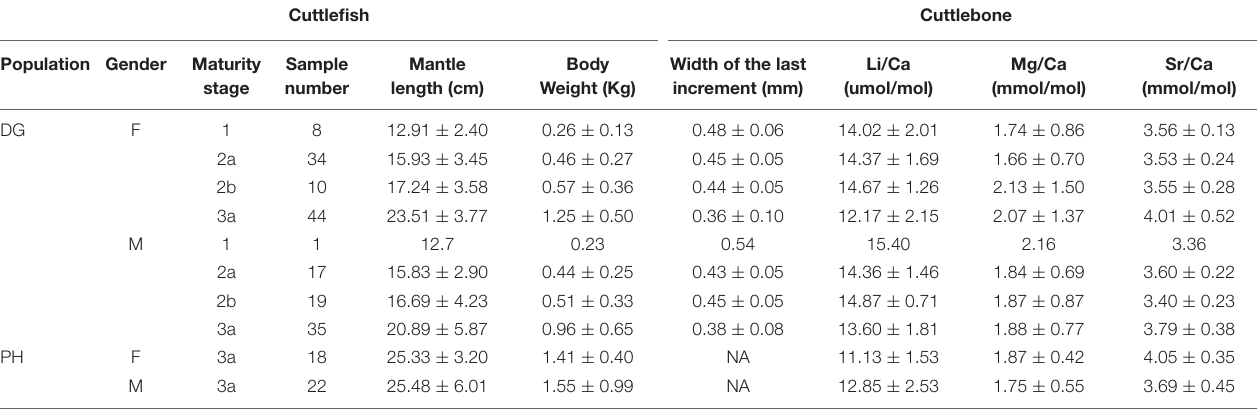
TABLE 2 | Wild cuttlefish data used to evaluate cuttlebone Me/Ca (element/calcium) ratios (1, immature; 2a, developing; 2b, maturing; and 3a, mature). Cuttlefish